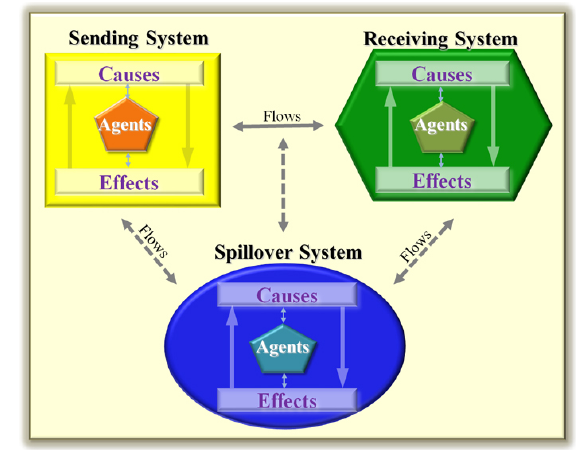
Fig. 2 . Five major and interrelated components of the telecoupling framework. The telecoupled system is hierarchically structured and is influenced by within-level and cross-level interactions. At the telecoupled system level, it includes a set of interacting coupled human and natural systems through flows. At the coupled system level, it consists of three interrelated components, agents, causes, effects. At the component level, each component has different attributes. Causes produce a telecoupling between at least two coupled human and natural systems, which generate effects that are manifested in one or more coupled human and natural systems. The telecoupling is made possible by agents nested within the systems that facilitate or hinder the unidirectional or bidirectional flows of material/energy or information among systems. Systems can be defined as sending, receiving, and/or spillover systems, depending on the directional movement of the flow considered. For the sake of simplicity, structure and processes, e.g., local couplings, within a coupled system are not shown except those that are directly related to telecouplings between